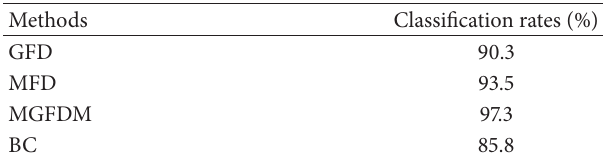
Table 1: Target classification accuracy of GFD, MFD, MGFDM, and BC methods.